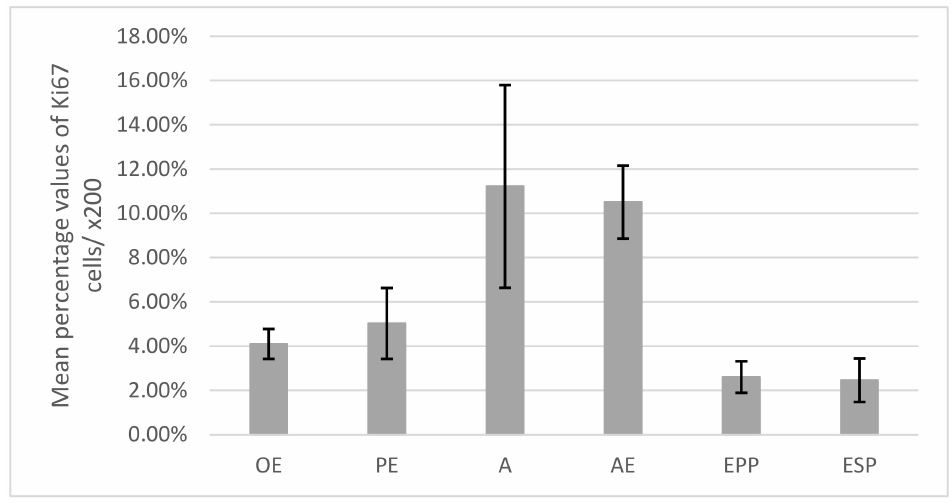
Scheme 3. Mean percentage values of Ki67+ cells/ × 200) depending on the location of the eu- topic/ectopic endometrium. OE = Ovarian endometriosis, PE = Peritoneal/pelvic endometriosis, A = Adeno-myosis, AE = Abdominal wall endometriosis, EPP = Endometrium—proliferative